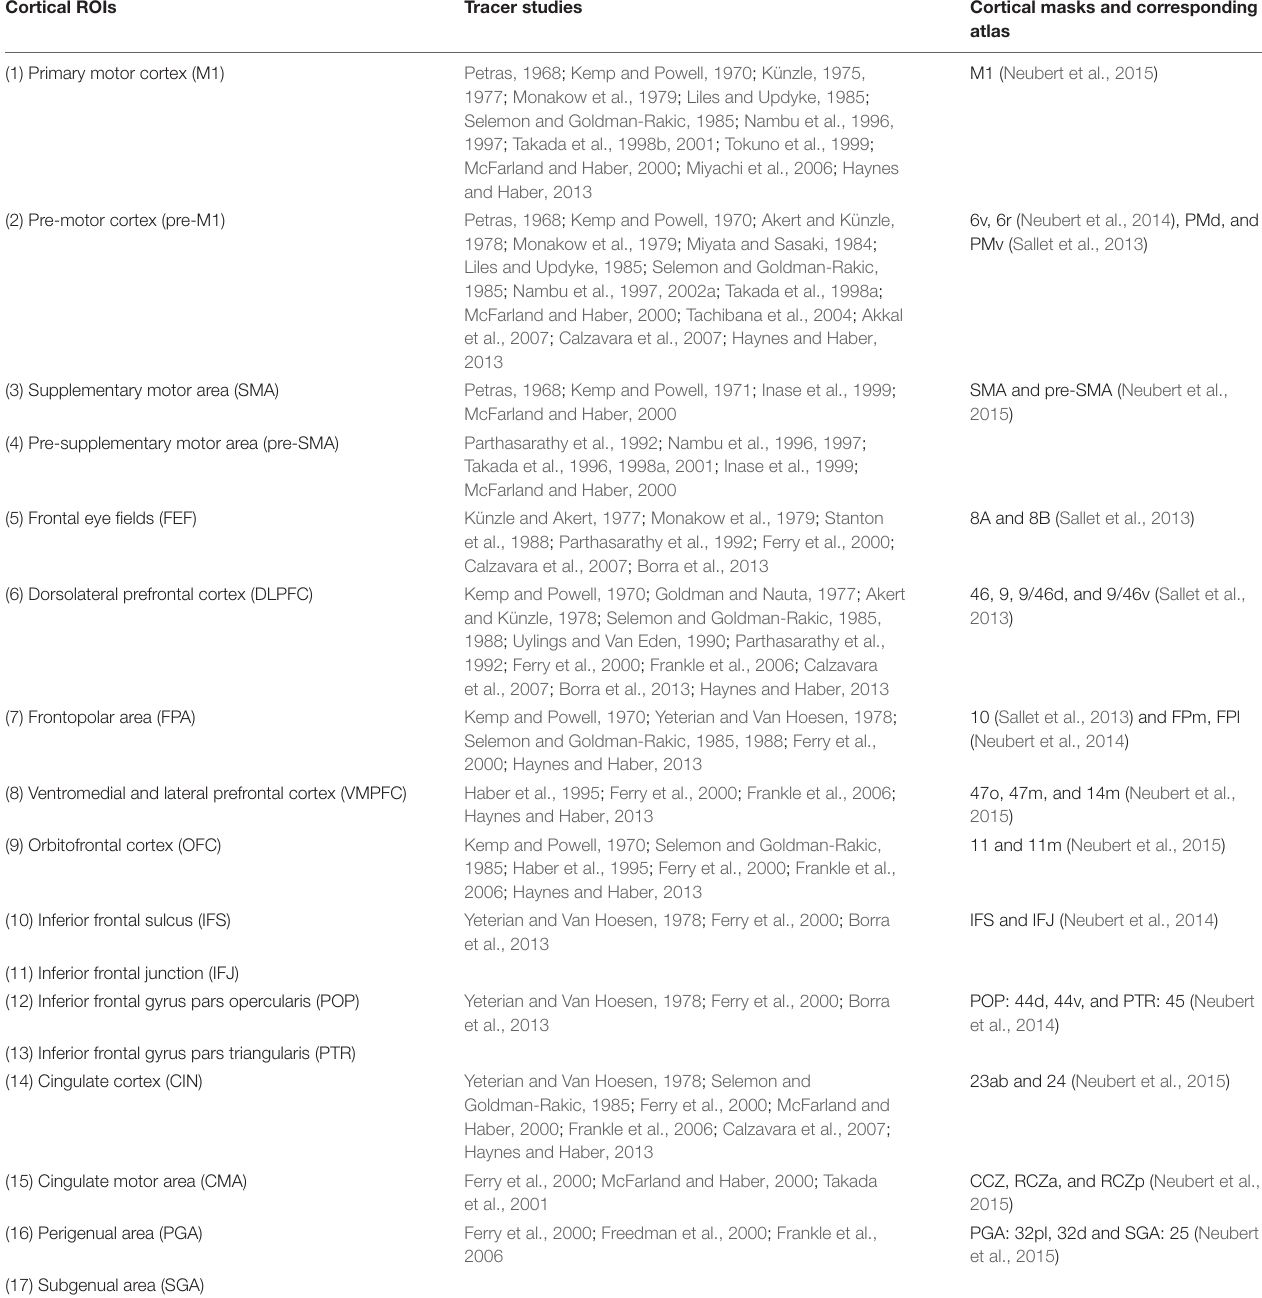
TABLE 1 | Cortical areas that connect both to the STR and STN based on tracer studies in non-human primates. Cortical ROIs Tracer studies Cortical masks and corresponding